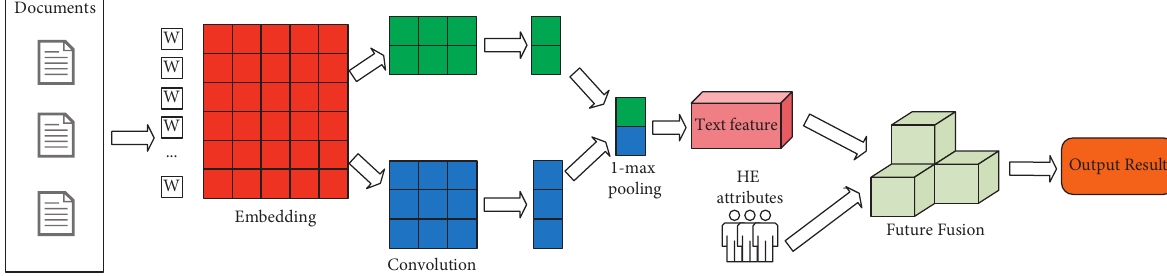
Figure 3: Framework of HE-CNN.